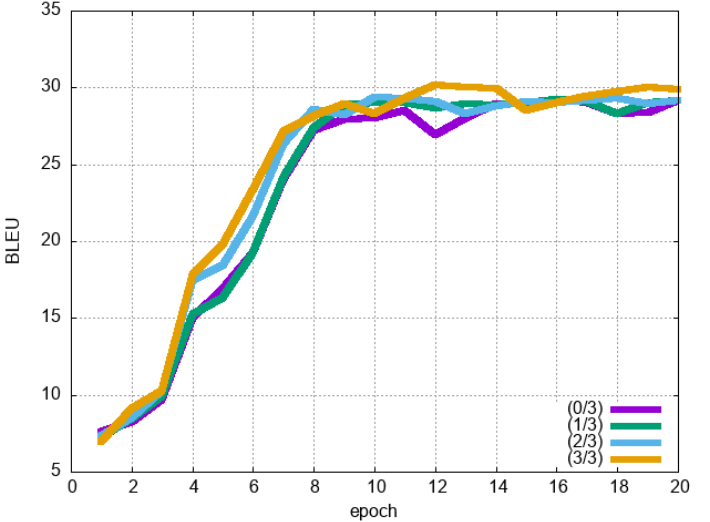
Figure 8. Results of the WMT14En-De